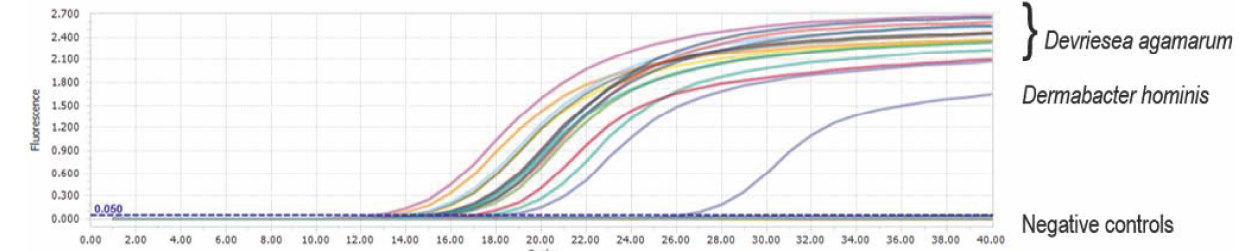
Figure 1. Two-step amplification carried out at 60 °C: All Devriesea agamarum isolates tested resulted in positive signals with CT values ranging from 12.61 to 18.54. Dermabacter hominis (blue curve) also gave a positive signal with a CT value of 26.29.